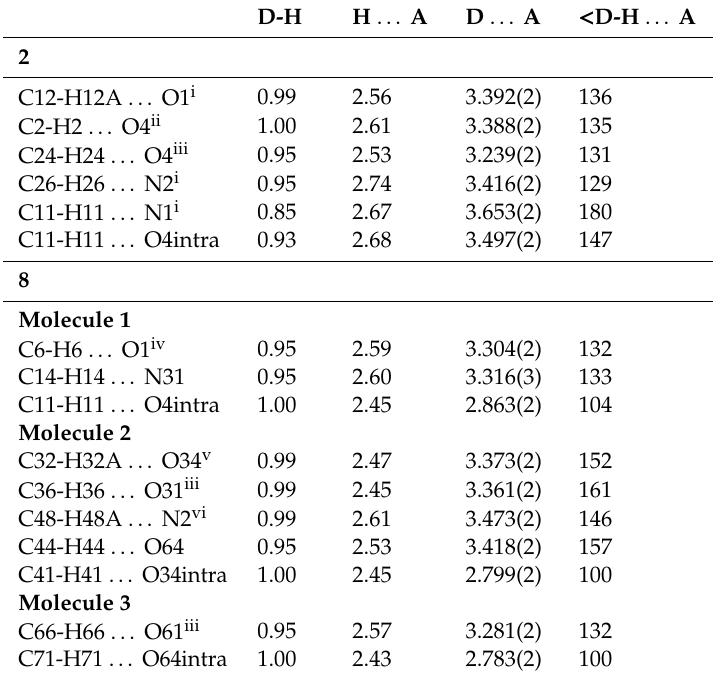
Figure 4. Partial molecular packing of 8 showing the 3-D network of hydrogen bonds. Table 2. Hydrogen bond geometry in